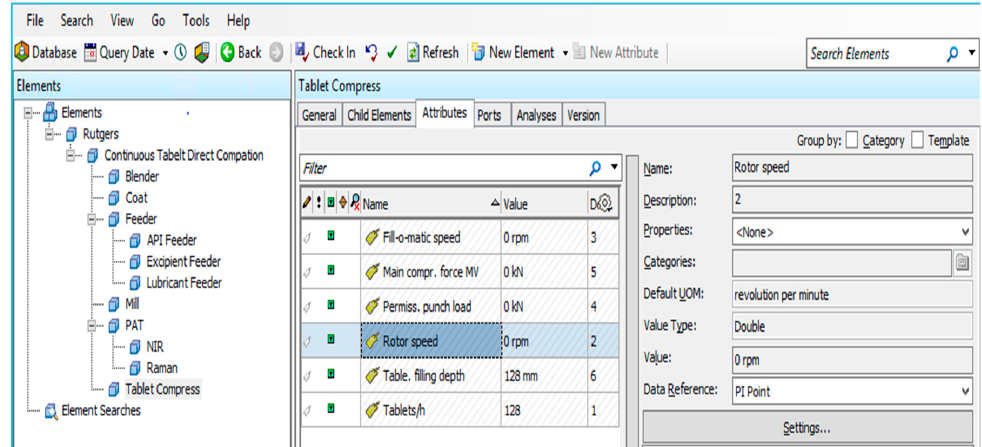
Figure 11. Include equipment into PI asset framework (AF) elements.